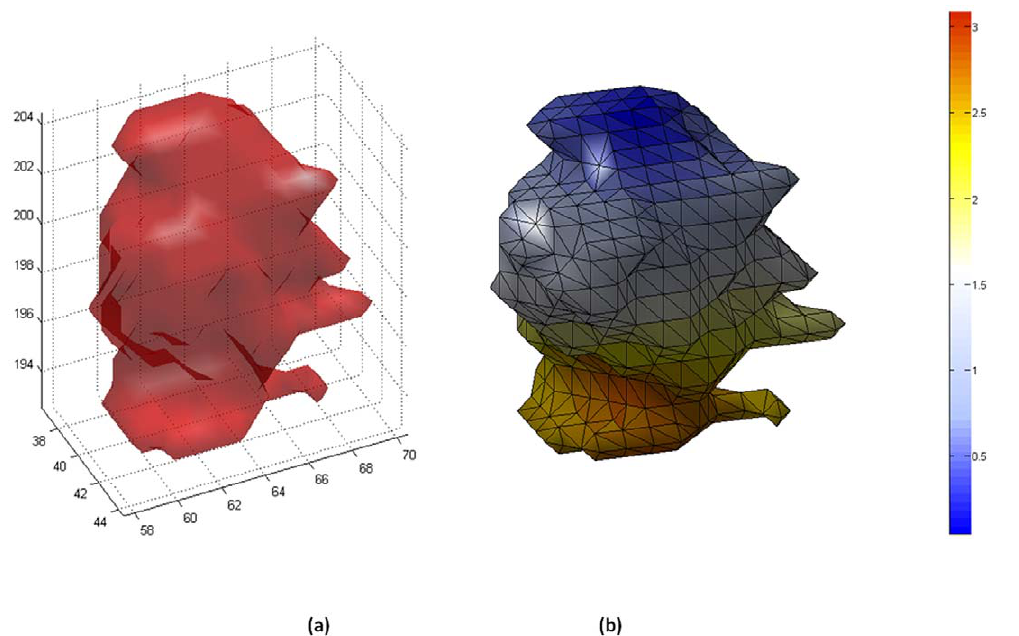
Figure 4. An example surface pair obtained from segmented uptake regions (i.e., non-specific mass from lung regions of a particular patient) is shown. We parameterize the surface (a) of lesion using Euler angles of boundary points, and we colorized the surface points with respect to those angles in radians (b). This shape information (i.e., circularity) was used in longitudinal assessment of uptake changes.